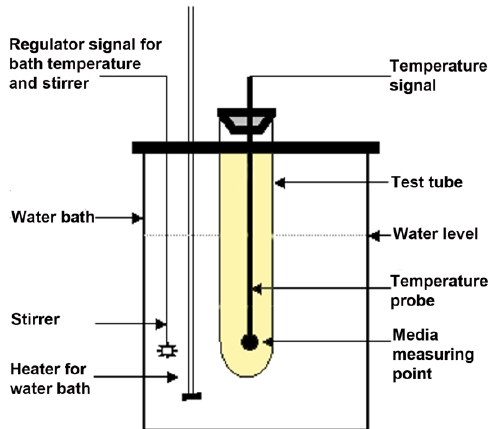
Figure 2. Schematic illustration of experimental setup for monitoring temperature characteristics of different PCM mixtures (yellow) in a water bath with temperatures cycling between 5 and 45 ◦ C. A temperature probe is located in the material to be tested. The test tube has a thin outside insulation (not shown) to dampen speed of temperature changes (see text). The water bath contains a heater, and a stirrer. The stirrer also carries a temperature probe, such that both the heater and the stirrer rpm is controlled by water temperature and temperature changes. Control test tubes (not shown) contain water, jellified water or a known PCM mixture.